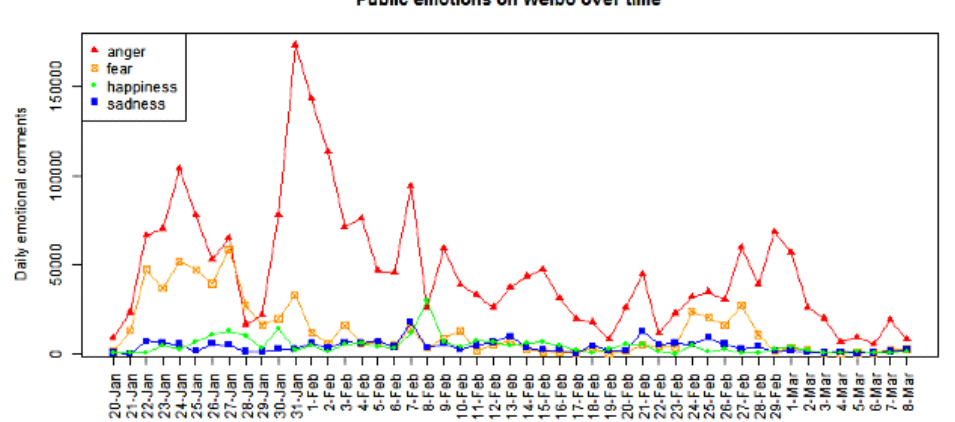
Figure 3. Trend of public emotions expressed on Weibo in the context of COVID-19 during the study period.